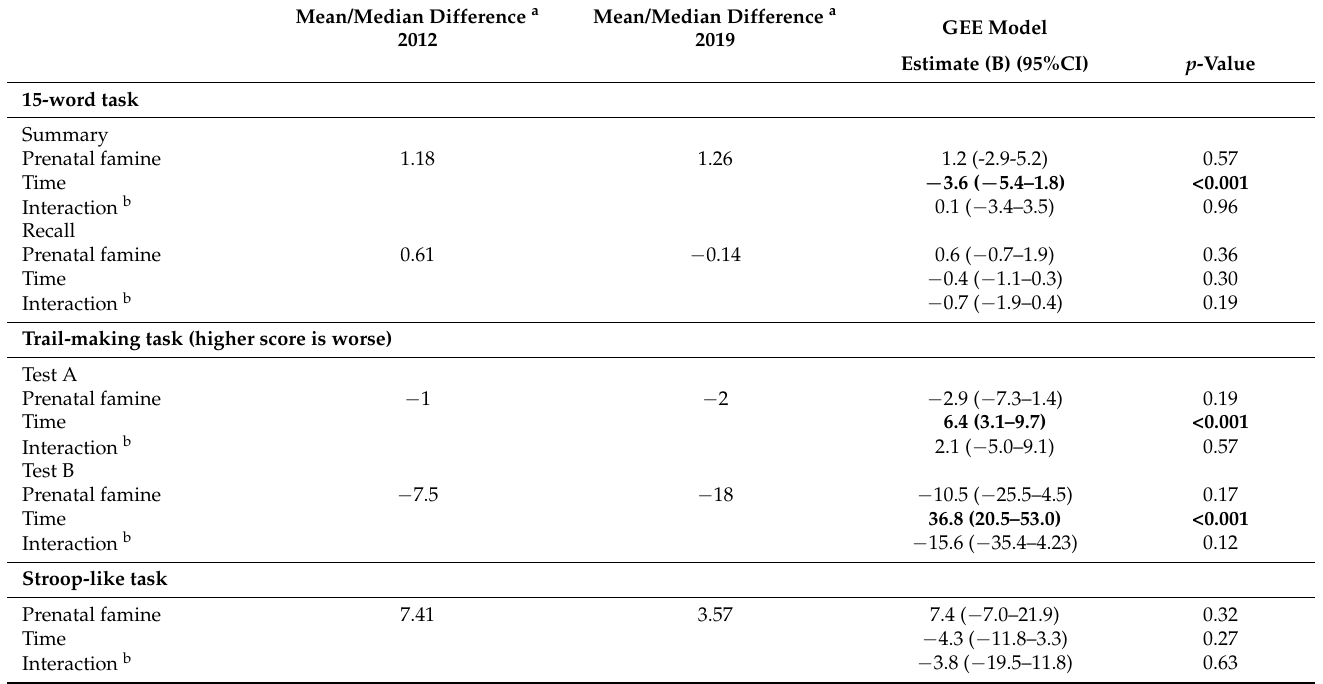
Table 4. Generalized estimation equation (GEE) models with ‘exposure × time’ interaction terms comparing cognitive outcomes between participants prenatally exposed to famine and unexposed participants.